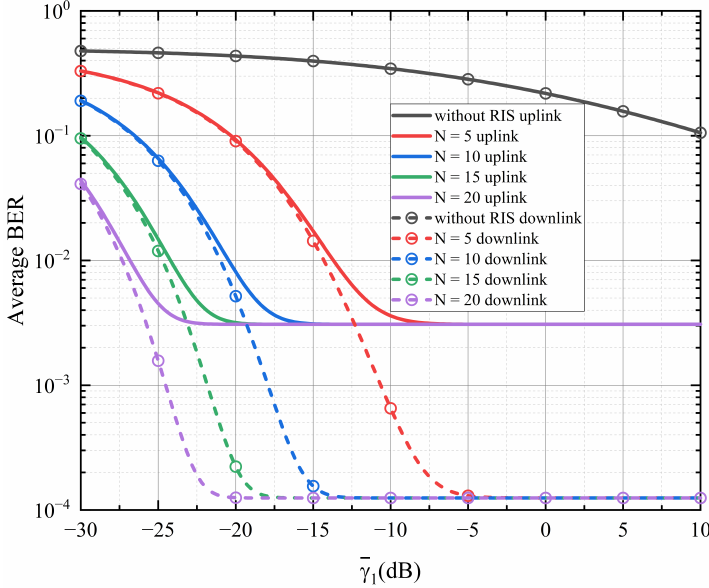
Figure 7. Average BER with different N when α = 4.0, β = 1.6, ξ = 10, γ 2 = 40 dB, d = 5.0 km, L = 32.